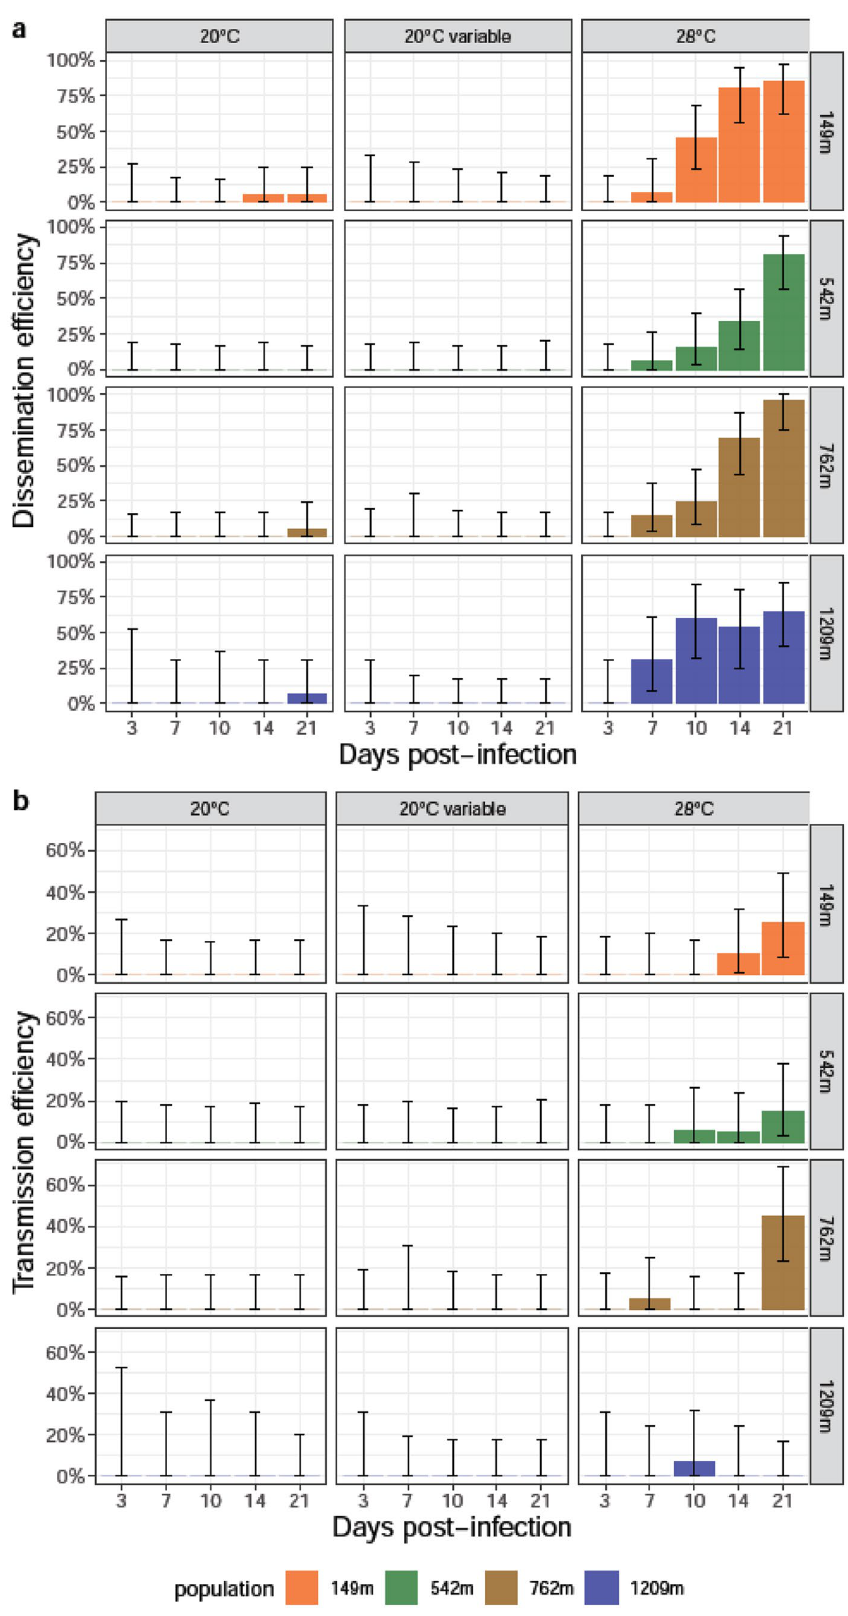
Figure 5. Dissemination and transmission efficiencies of Ae. albopictus populations infected with DENV examined at different days (3, 7, 10, 14, and 21) after incubation at different temperatures (20 °C, 20 °C variable, 28 °C). After infection, mosquito heads and saliva were titrated. ( a ) Dissemination efficiency corresponds to the proportion of mosquitoes with infected heads. ( b ) Transmission efficiency refers to the proportion of mosquitoes with infectious saliva. Error bars show the exact Binomial confidence interval